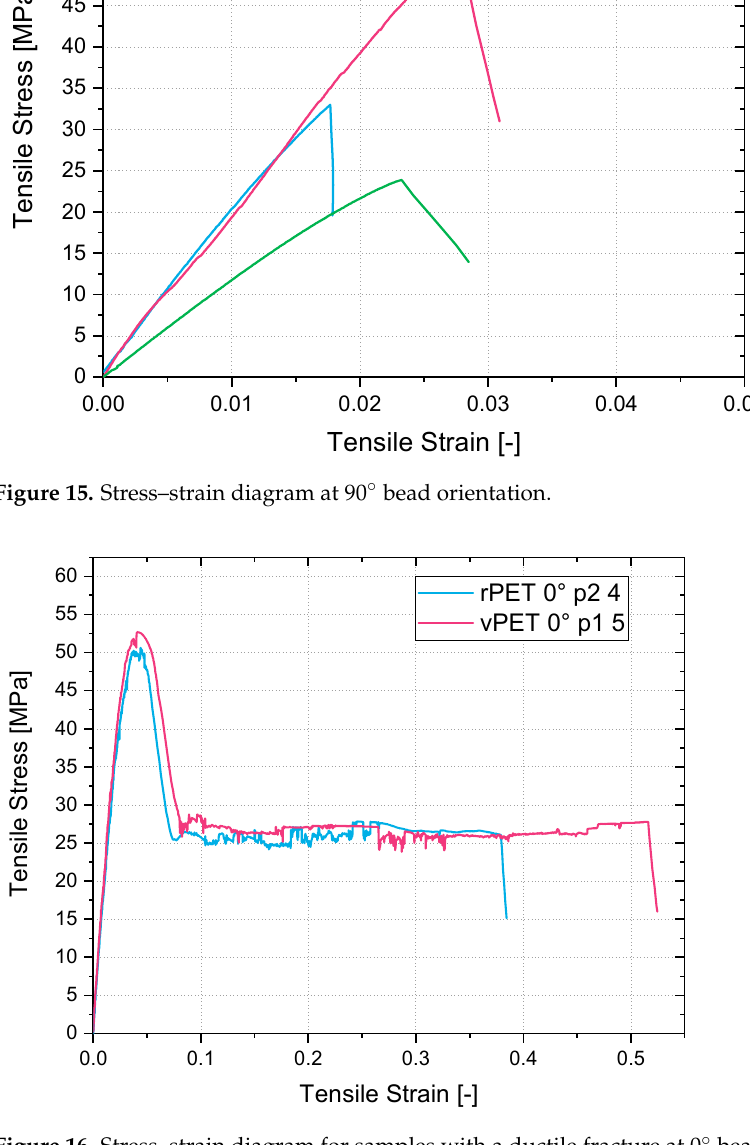
Figure 15. Stress–strain diagram at 90° bead orientation.